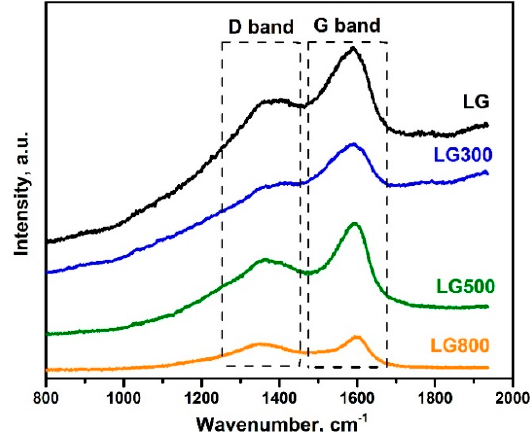
Figure 1. XRD patterns of pristine lignite and as-produced chars ( a ), closer inspection of XRD patterns ( b ).